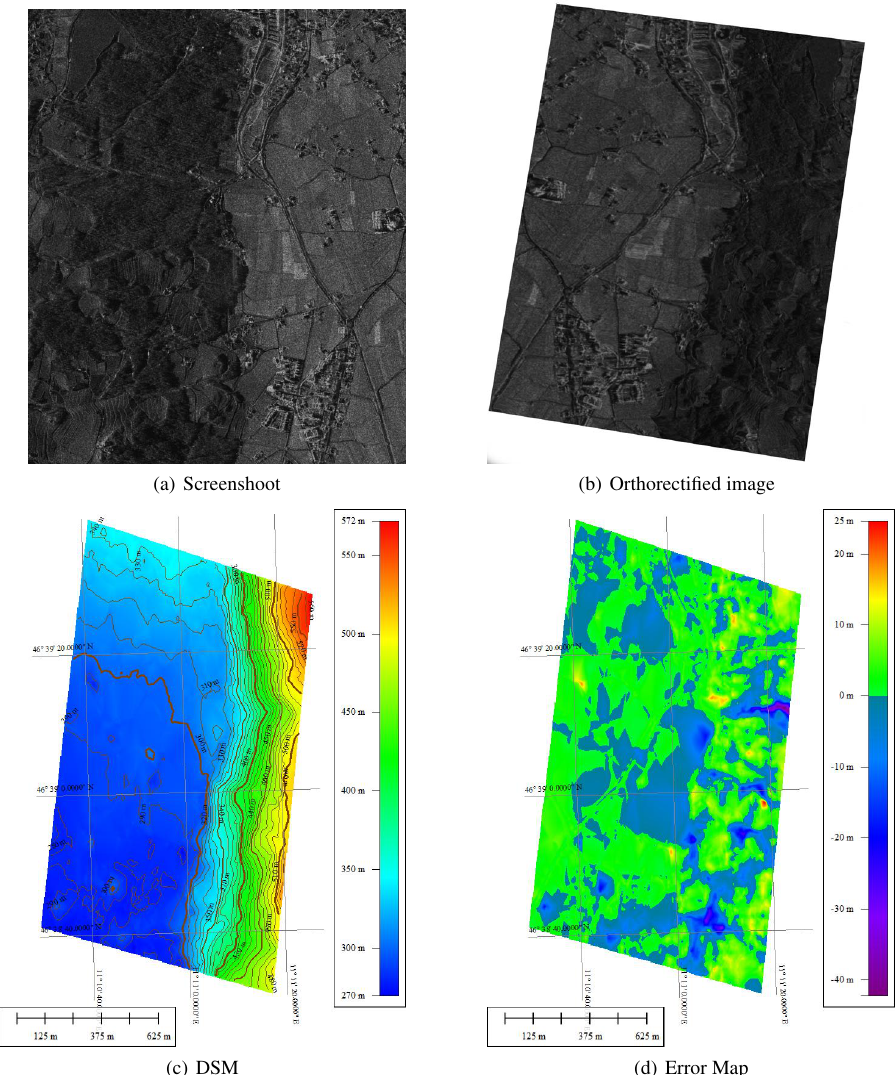
Figure 2: COSMO-SkyMed Tile 1 Analysis